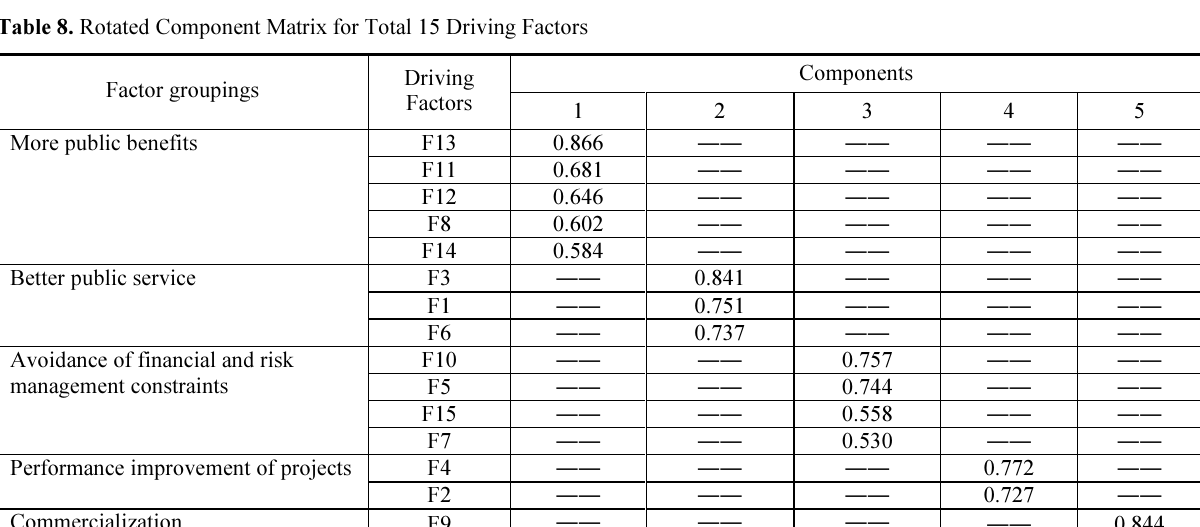
Table 8. Rotated Component Matrix for Total 15 Driving